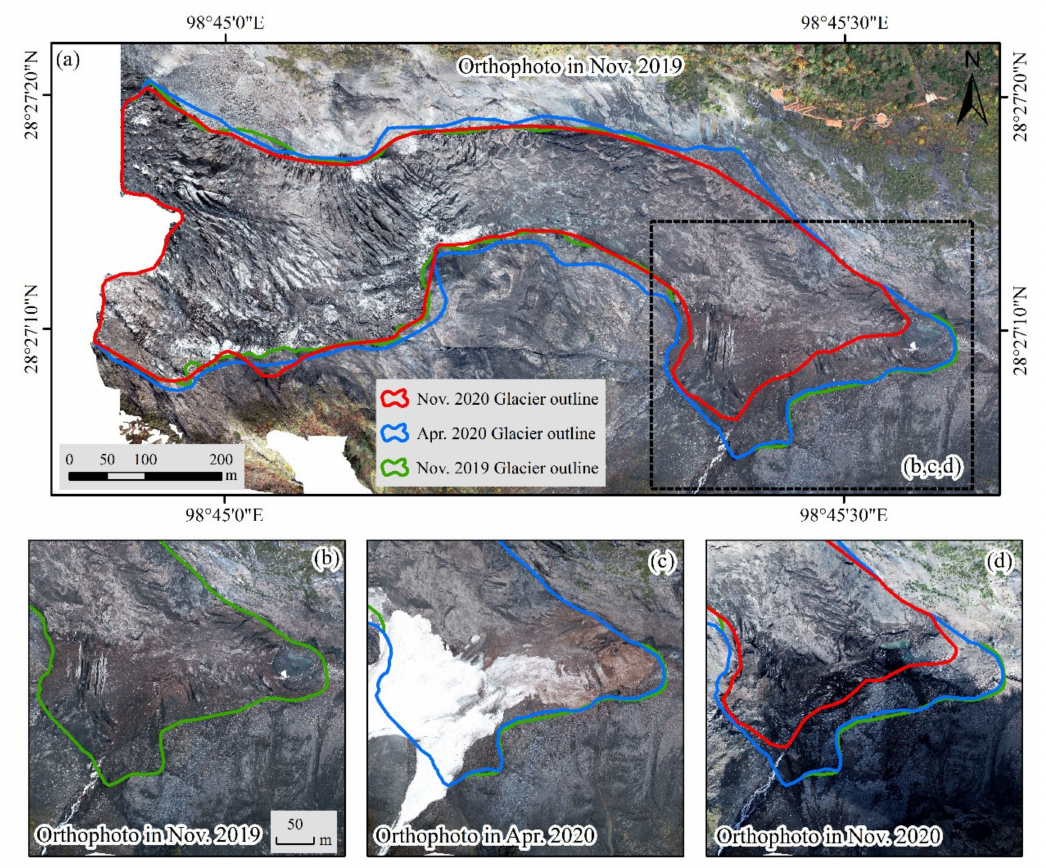
Figure 6. Changes in glacier terminus during surveys. ( a ) The orthophoto in November 2019 with glacier outlines in different times. ( b – d ) The orthophotos in November 2019, April 2020 and November 2020 with glacier